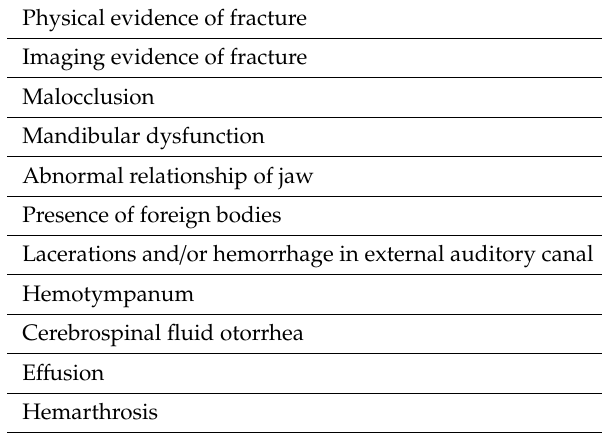
Table 2. The American Association of Oral and Maxillofacial Surgery (AAOMS) special committee on parameters of care indications for open reduction